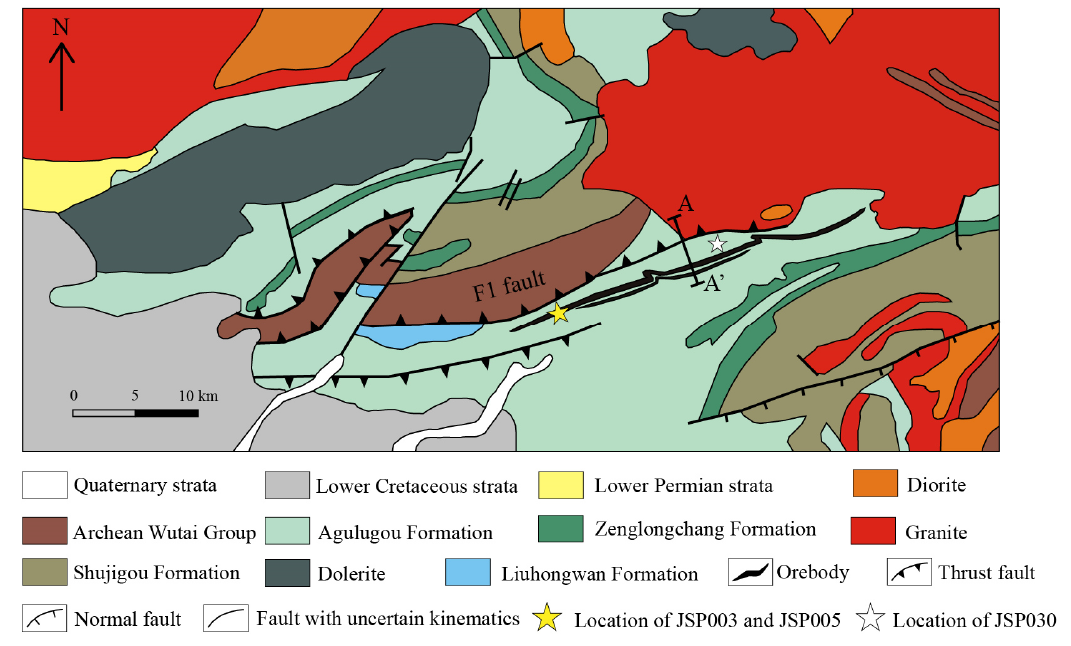
Figure 2. Geological map of the Jiashengpan deposit; modified from [4].